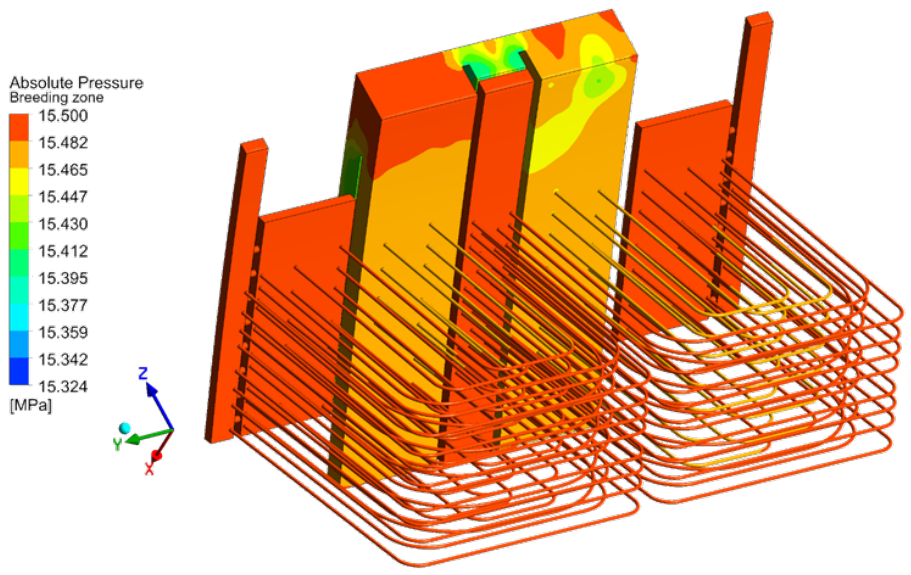
Figure 11. Absolute pressure distribution in the BZ cooling